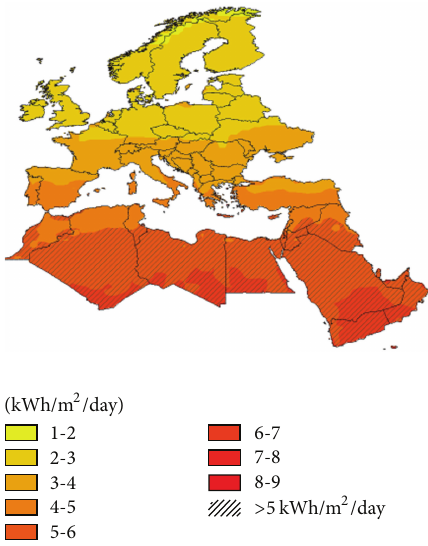
Figure 9: Egypt’s Solar Potential.